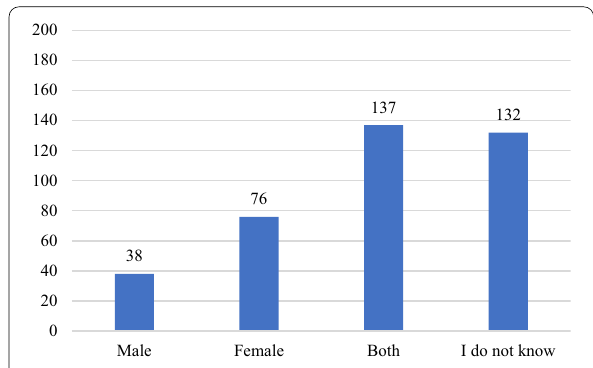
Fig. 7 Gender of migraine patients as perceived by the population of the study